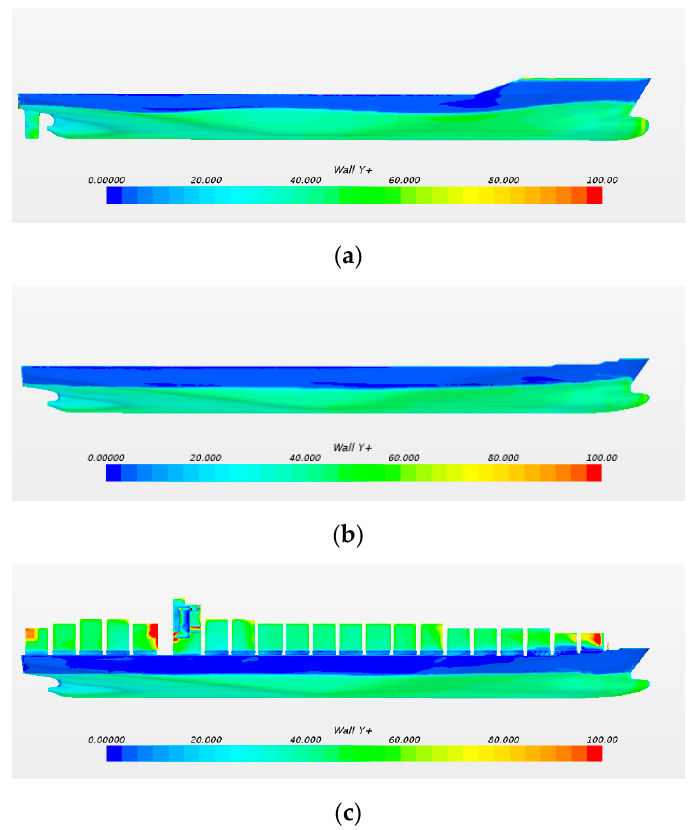
Figure 4. Y + entire area of the hull. ( a ) KCS, ( b ) 8000 TEU-class container ship without superstructure, and ( c ) 8000 TEU-class container ship with superstructure. Table 3. Results of the grid dependency test of the 8000 TEU container ship, with superstructure. F 𝑭 𝑵 0.274